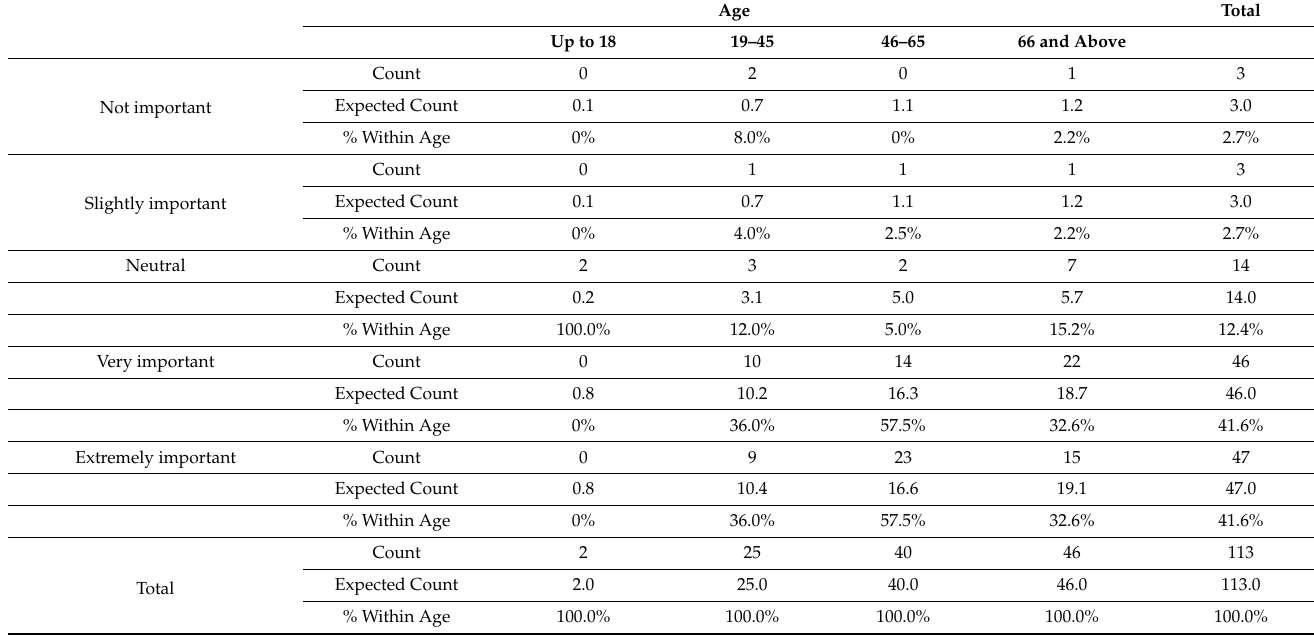
Table 9. Importance of Trust for Working with the JSU JHS CORC by Age.